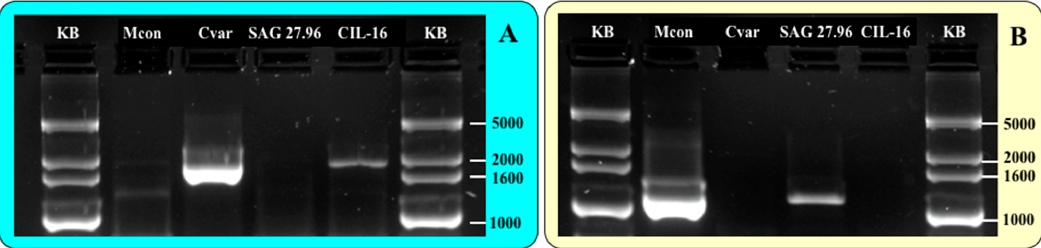
Figure 4. Diagnostic PCR using the primer combinations CvarF/ITS055R ( A ) and MconF/ITS055R ( B ). Mcon — Micractinium conductrix (SAG 241.80); Cvar — Chlorella variabilis (CCAP 211/84); reference hosts: Paramecium bursaria strains SAG 27.96 and strain CIL-16.